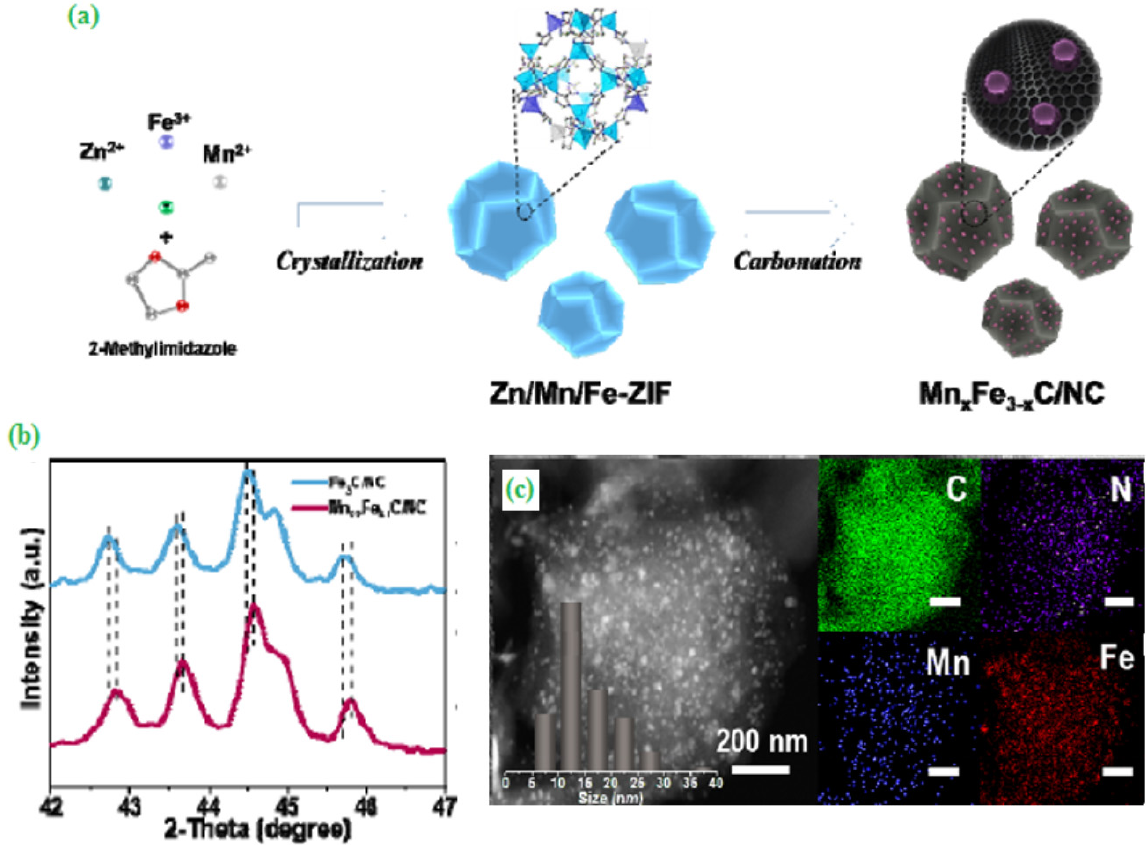
Figure 3. ( a ) The schematic diagram for the fabrication process of MnxFe 3-x C/NC catalyst, ( b ) XRD patterns of Fe 3 C/NC and Mn 0.9 Fe 2.1 C/NC, ( c ) STEM image with its corresponding elemental map- pings for C, N, Mn, and Fe of the Mn 0.9 Fe 2.1 C/NC catalyst. Copyright 2019 by American Chemical Society [48].